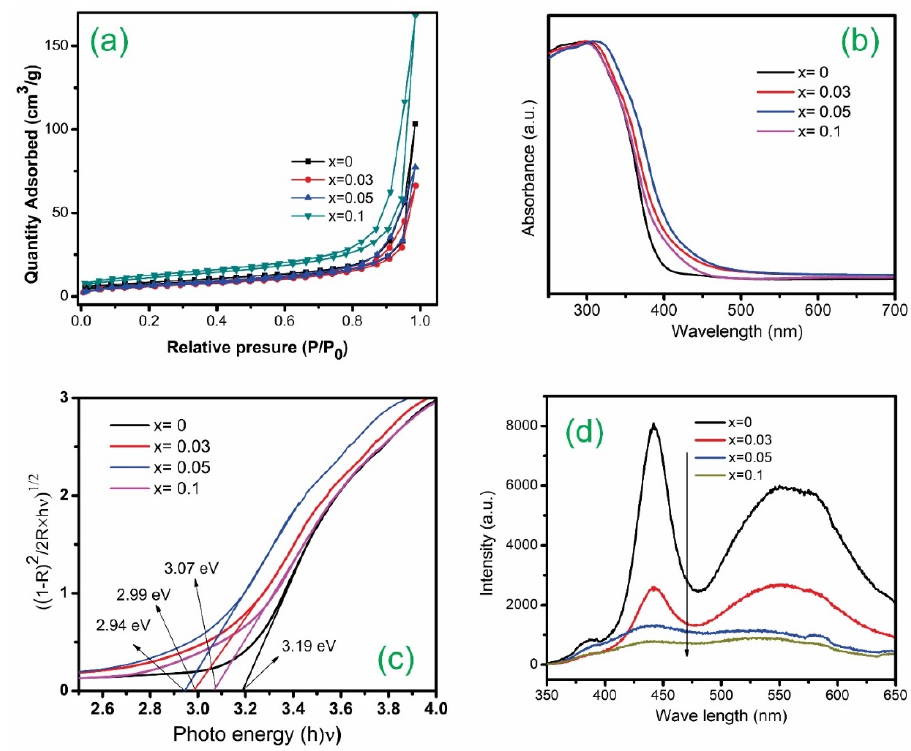
Figure 3. The characterizations of the Sr 1 − x La x TiO 3 samples with the optional doping rate (x = 0, 0.03, 0.05, 0.1): ( a ) nitrogen adsorption–desorption isotherms; ( b ) UV-Vis diffuse reflectance spectra; ( c ) calculated bandgap; and ( d ) PL spectrum.